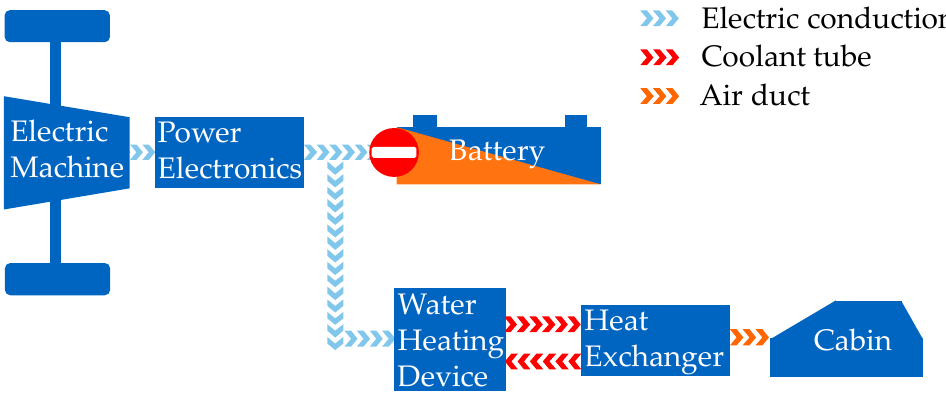
Figure 1. Schematic diagram of the electric drive train and heating circuit.